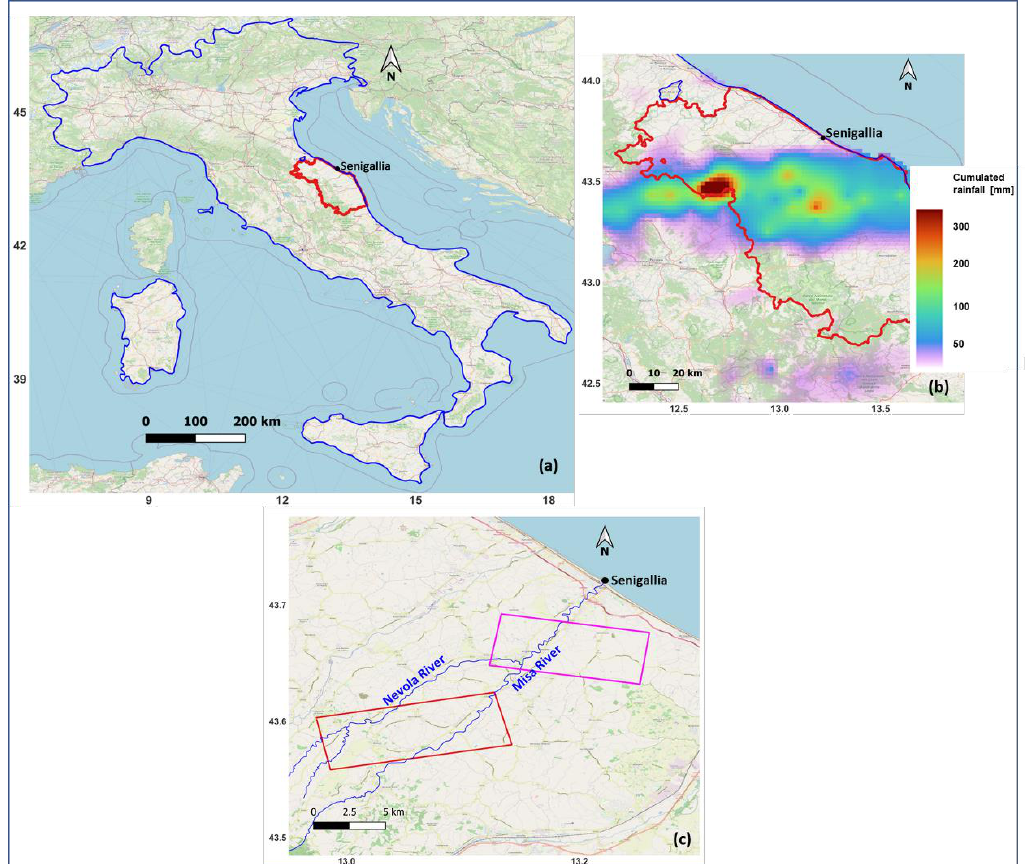
Figure 1. Upper left panel ( a ): boundaries of Italy (blue) and of the Marche region (red) superimposed over an OpenStreetMap ® layer. Upper right panel ( b ): rainfall cumulated on 15 September 2022 between 12:00 and 24:00 (local time), recorded by the stations in the area affected by the flood (a spatial interpolation was performed). Lower panel ( c ): areas imaged by CSG on 17 (magenta rectangle) and 18 (red rectangle) September 2022.